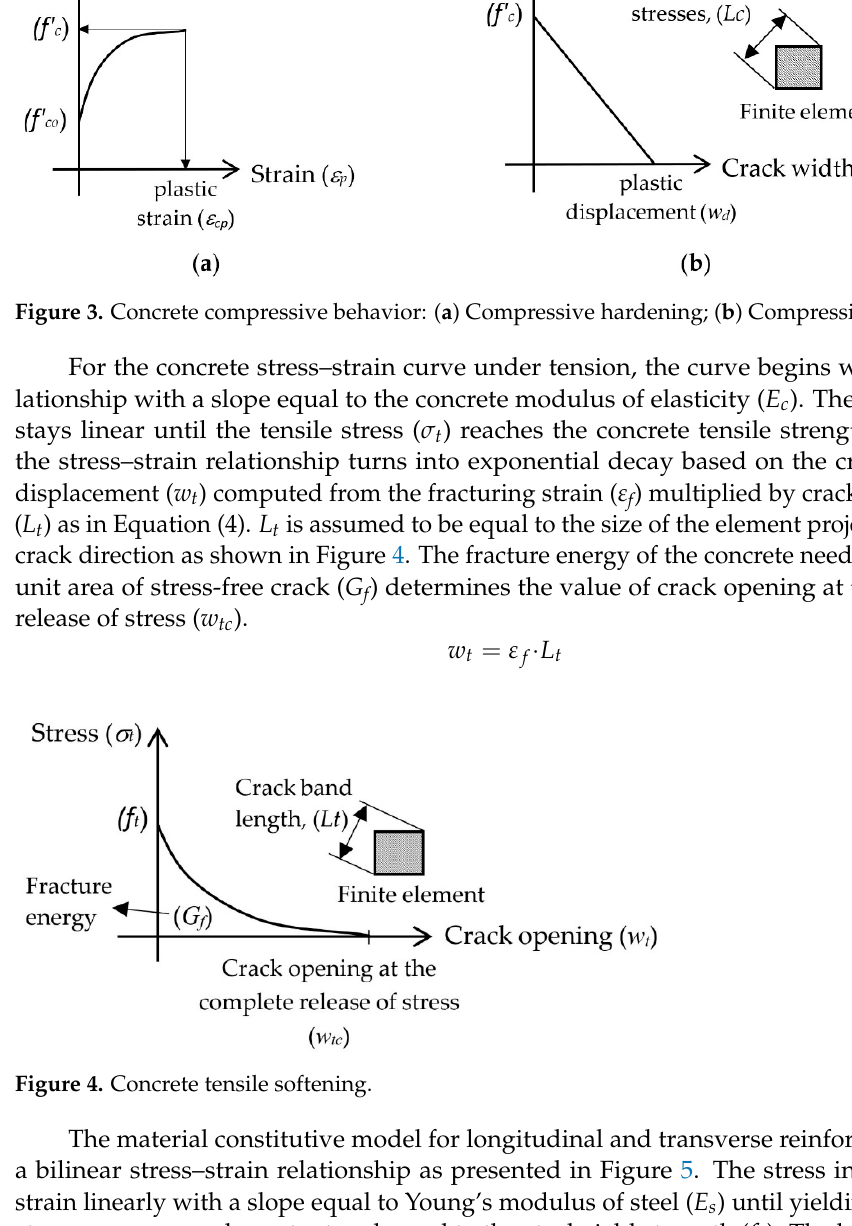
Figure 5. Bilinear stress–strain response of steel bars.